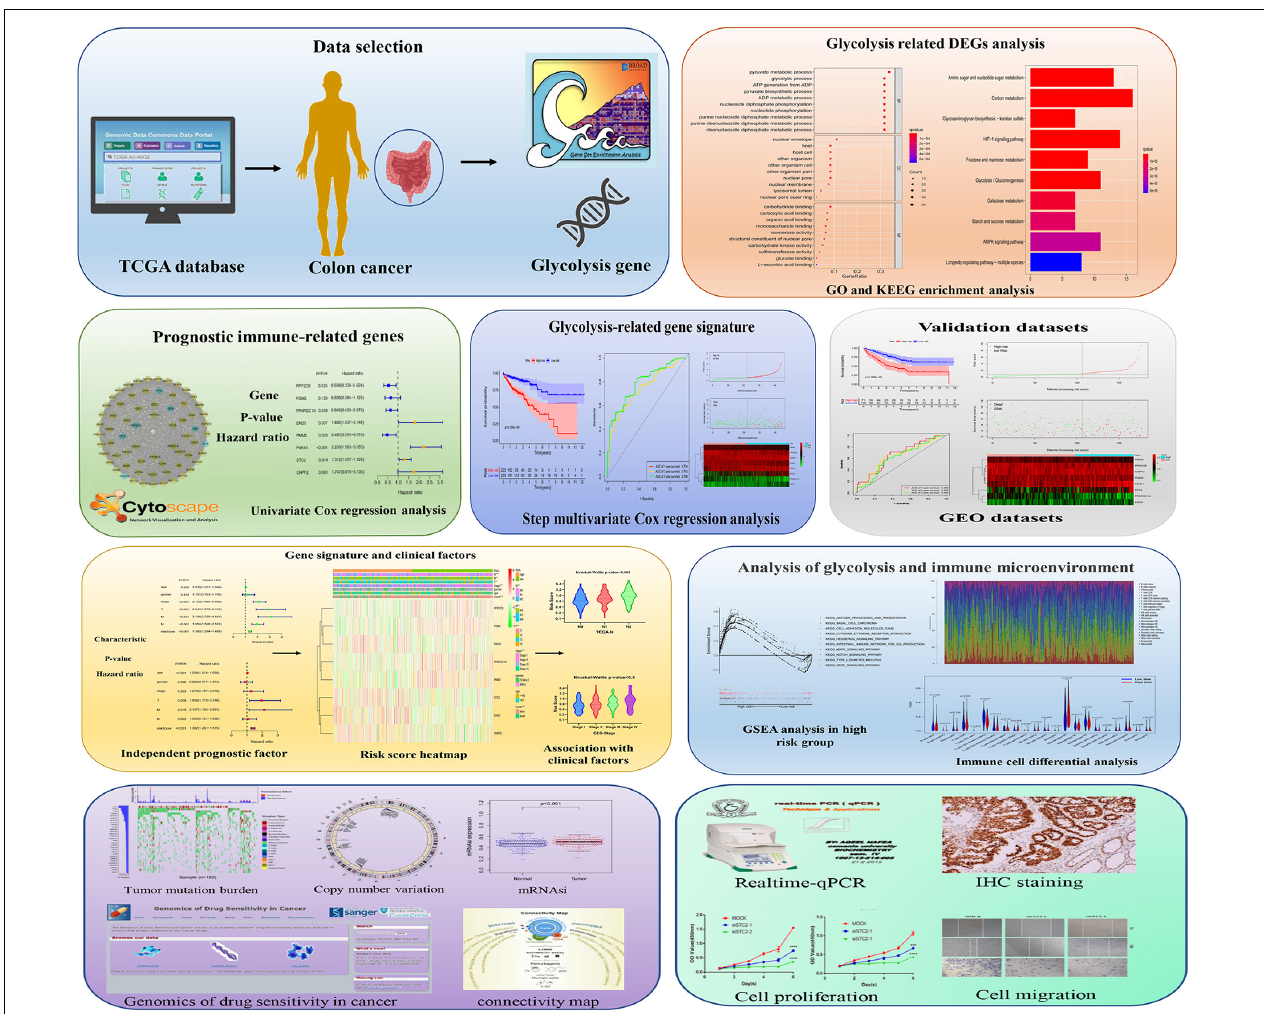
FIGURE 1 | Schematic diagram of the comprehensive analysis of glycolysis-related genes (GRGs) for prognosis prediction and drug selection in colon adenocarcinoma (COAD) patients.